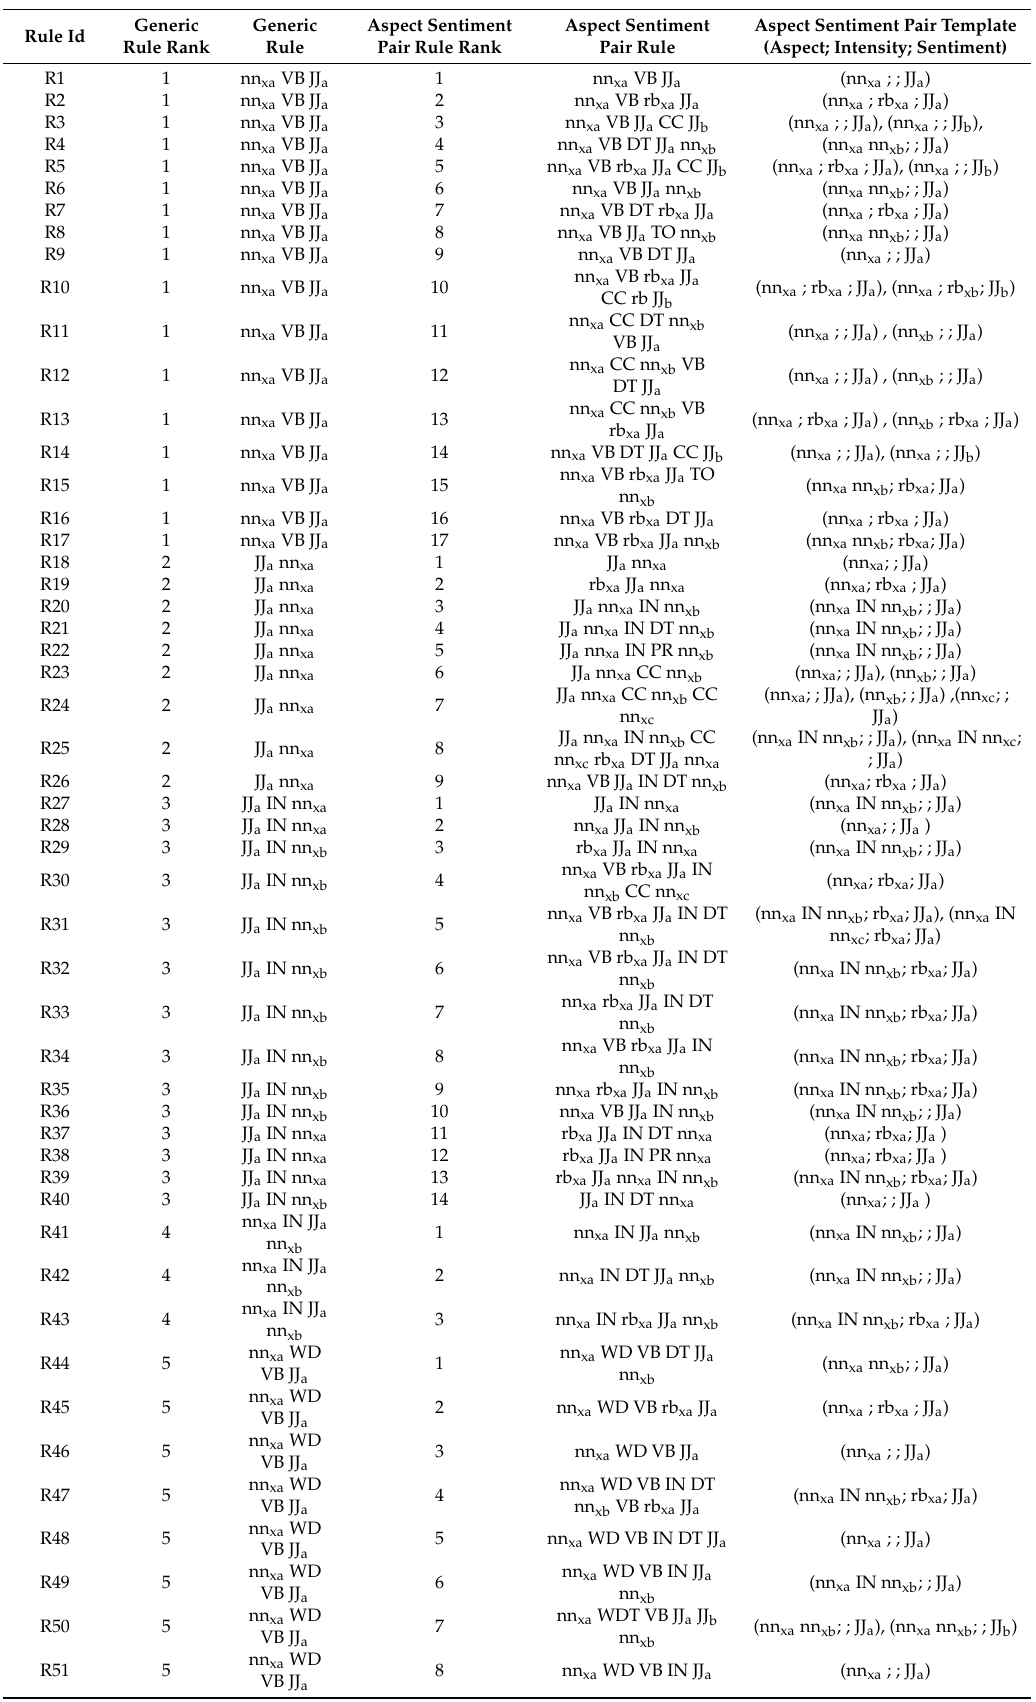
Table 10. Generic rules, aspect-sentiment pair rules, and aspect-sentiment pair